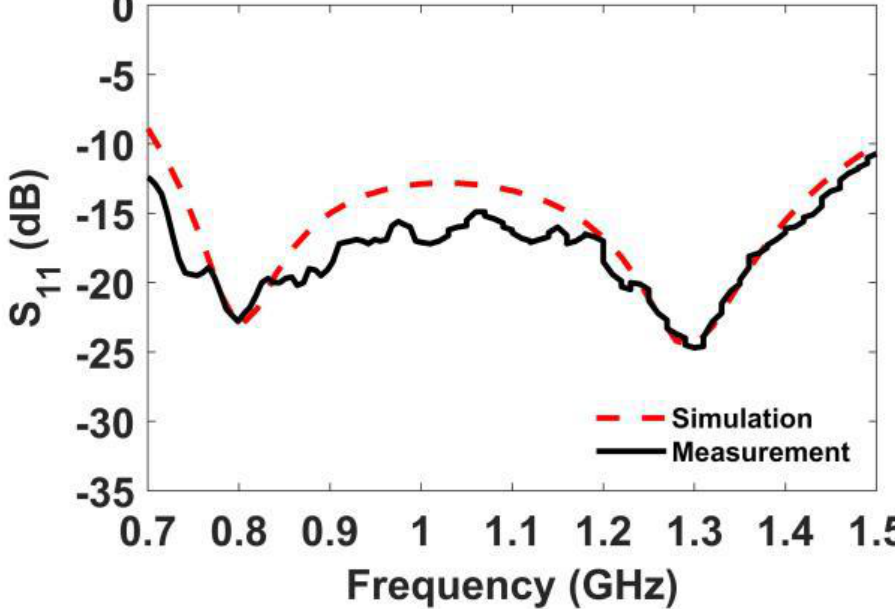
Figure 11. Simulation and measurement results (S 11 ) of the proposed UHF antenna.